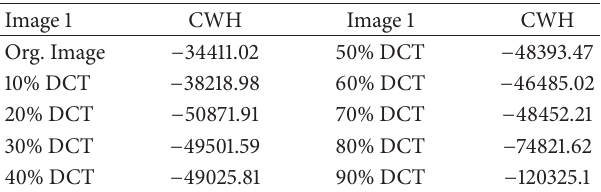
Table 1: Original and compressed images with their